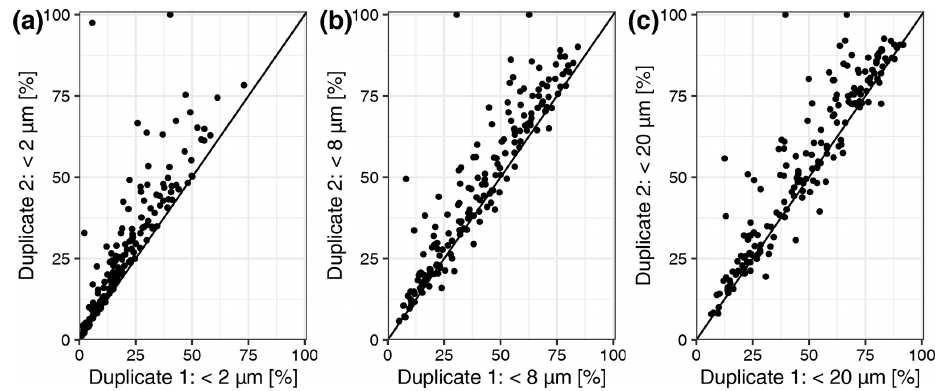
Figure A1. Scatterplot of duplicate measurements for the particle size distribution data. (a) Duplicate 1 and 2 < 2µm. (b) Duplicate 1 and 2 < 8µm. (c) Duplicate 1 and 2 < 20µm.